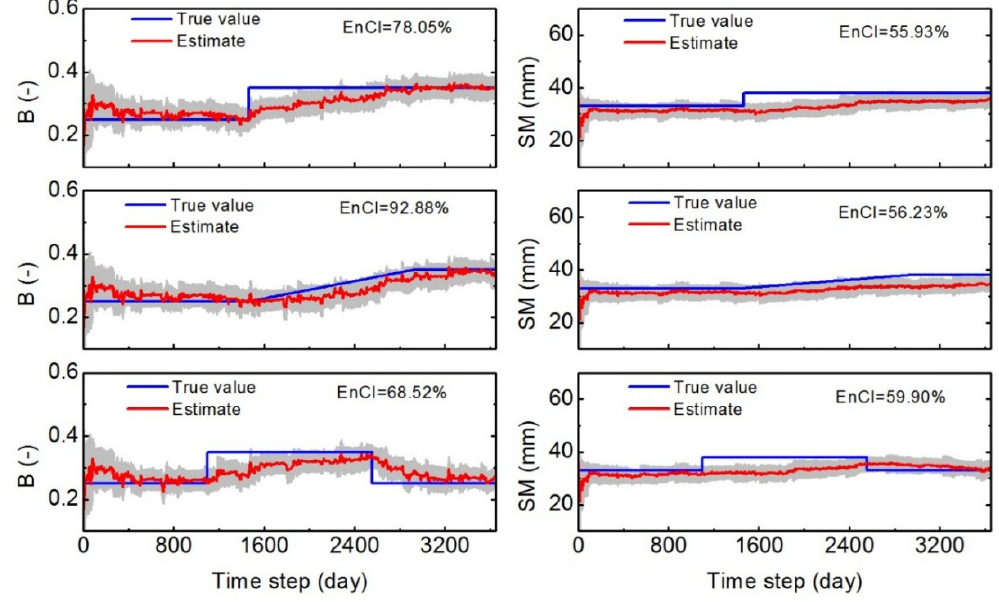
Figure 5. Tracing parameter changes regarding the three non-stationary cases for the scenario of Medial_Level uncertainty: the sudden change ( top panel ); the gradual change ( middle panel ) and the rotational change ( bottom panel ).